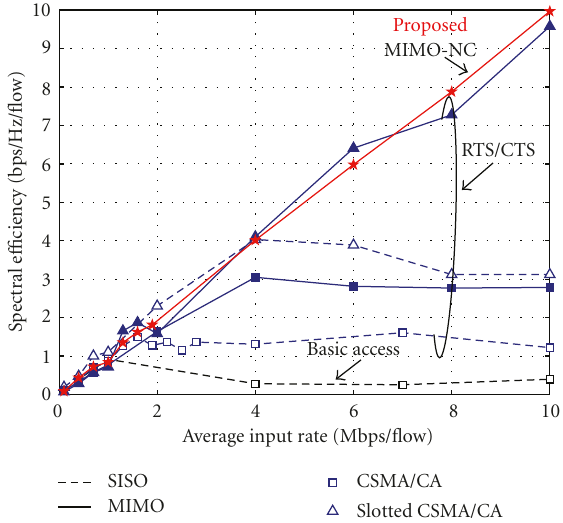
Figure 13: Throughput performance comparison of CSMA/CA and MIMO network coding.